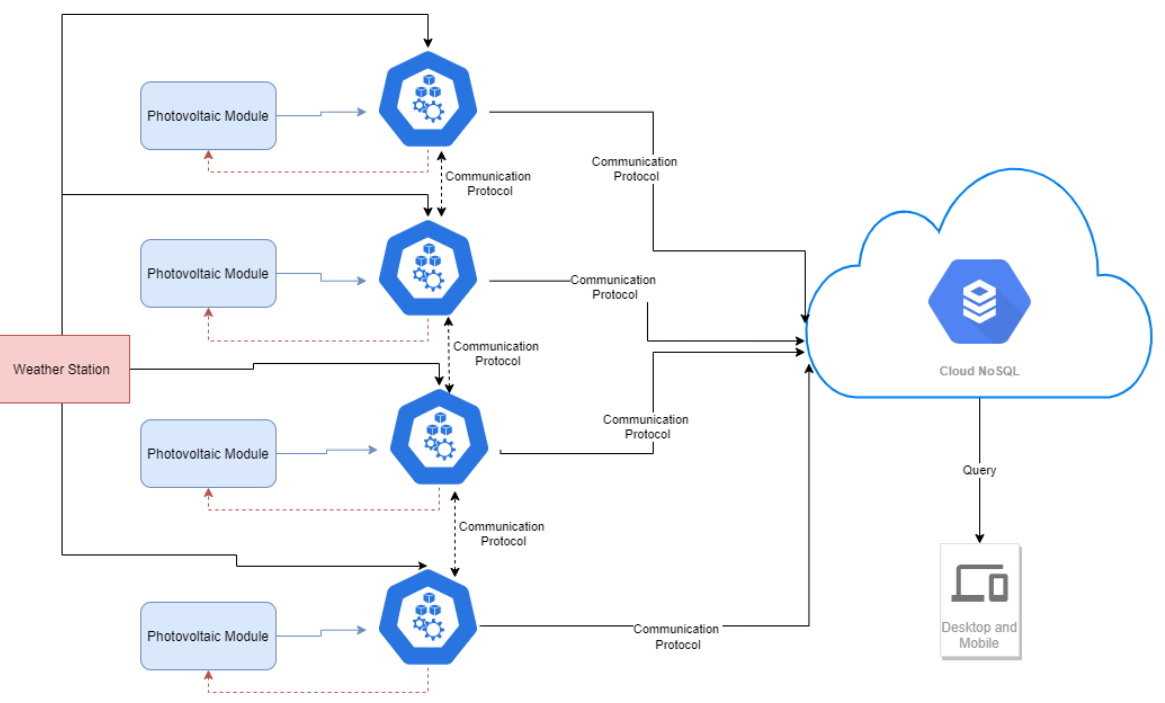
Figure 9. Component scheme of the architectural